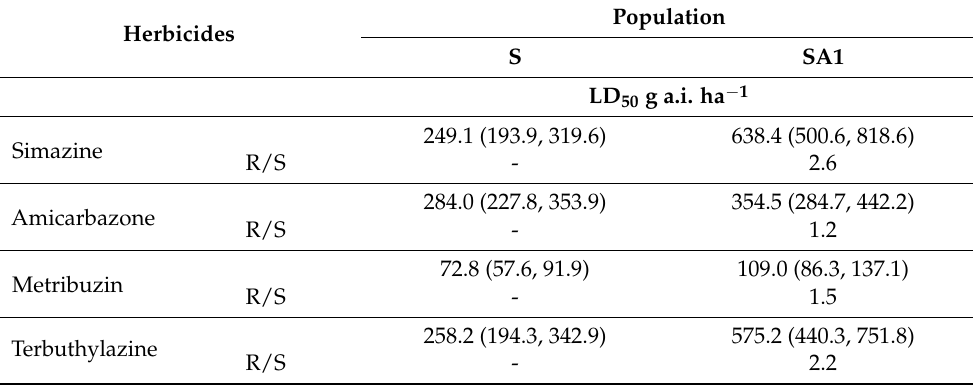
Table 7. The dose required for 50% mortality (LD 50 ) of susceptible (S) and trial site population (SA1) to various PSII inhibiting herbicides with 95% confidence intervals (CI) in parentheses. R/S is the ratio of LD 50 of resistant and susceptible